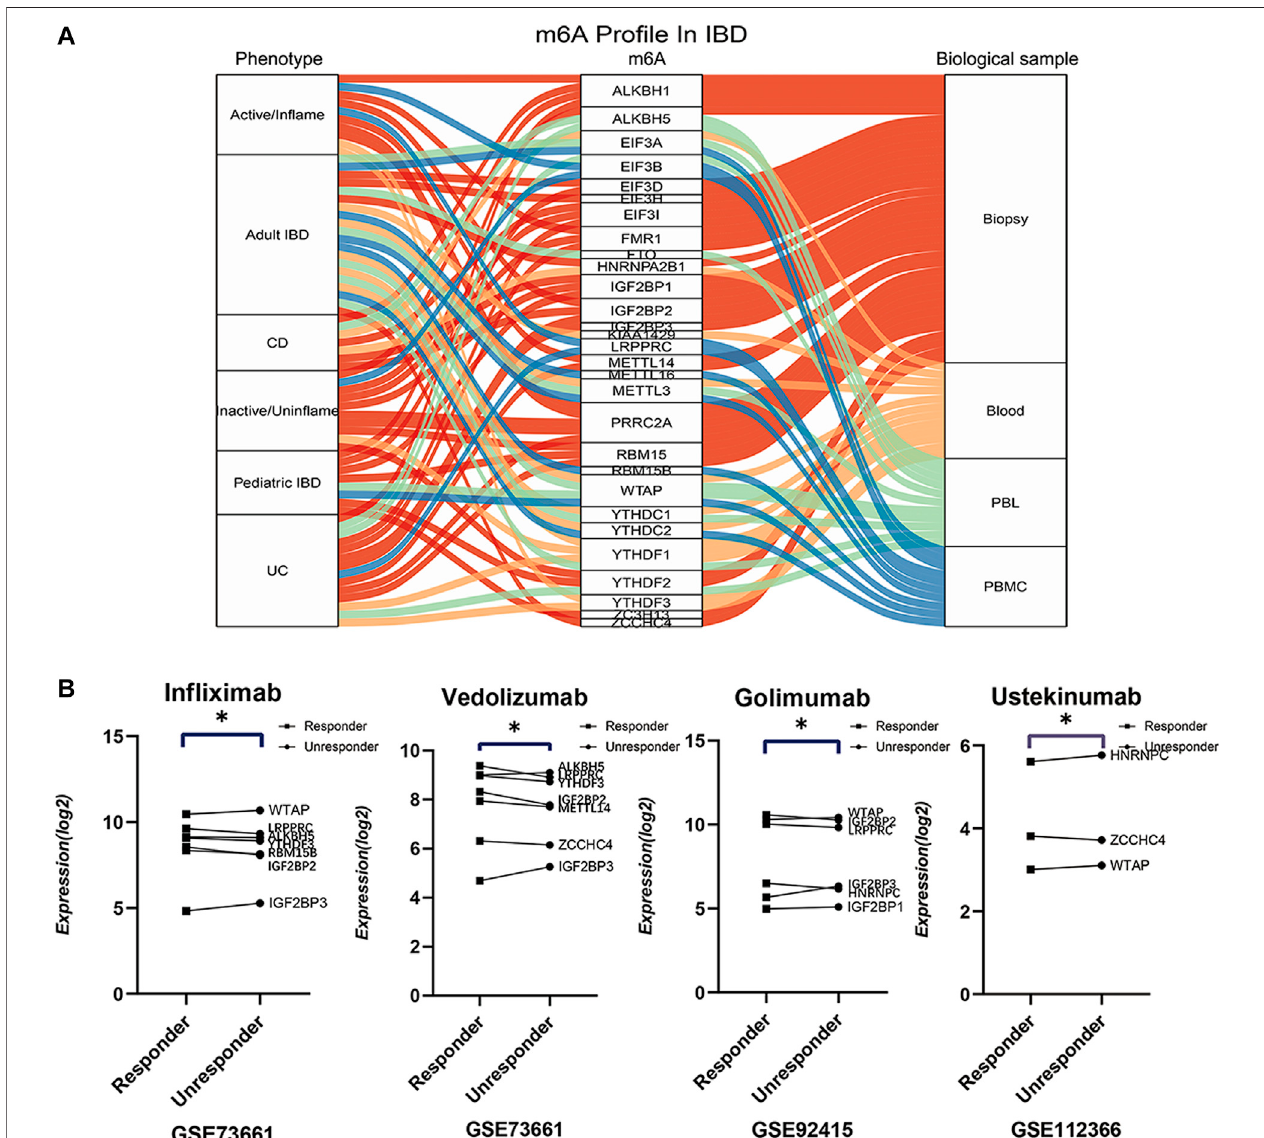
FIGURE 6 | The globally differential expressions of m6A readers, writers and erasers in different phenotypes, sample sources, patient groups, and therapeutic response subgroups. (A) is the sankey diagram of differential m6A regulators between different phenotypes, sample sources, patient groups. (B) is the top differential m6A regulators between responder and unresponder by biologics such as in fl iximab, vedolizumab, golimumab, and ustekinumab.